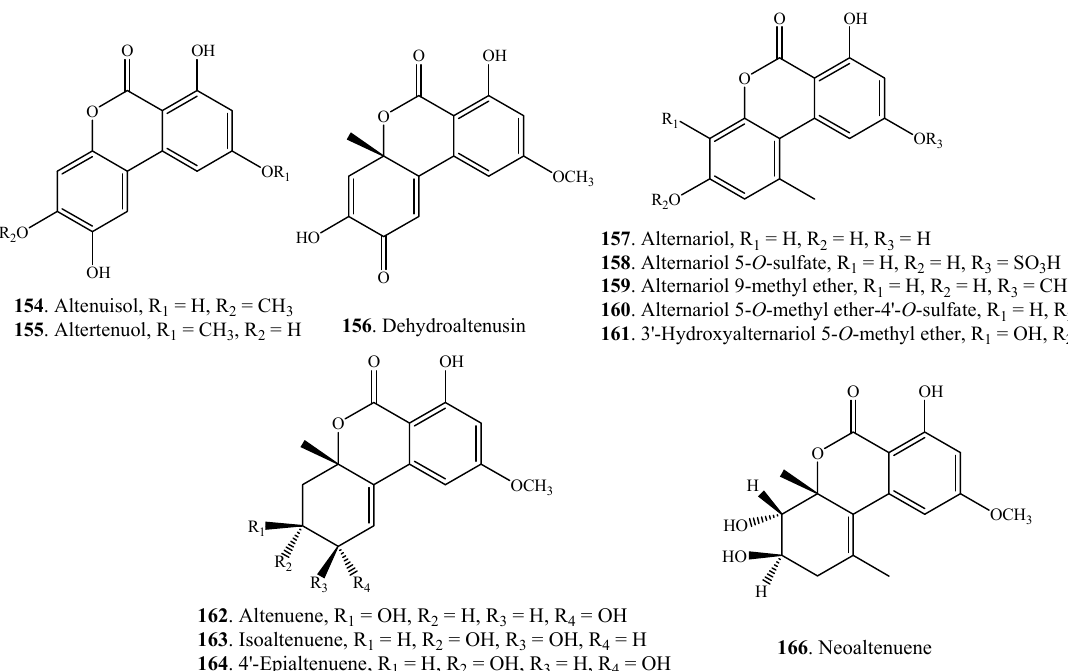
Figure 8. Dibenzopyranones isolated from Alternaria